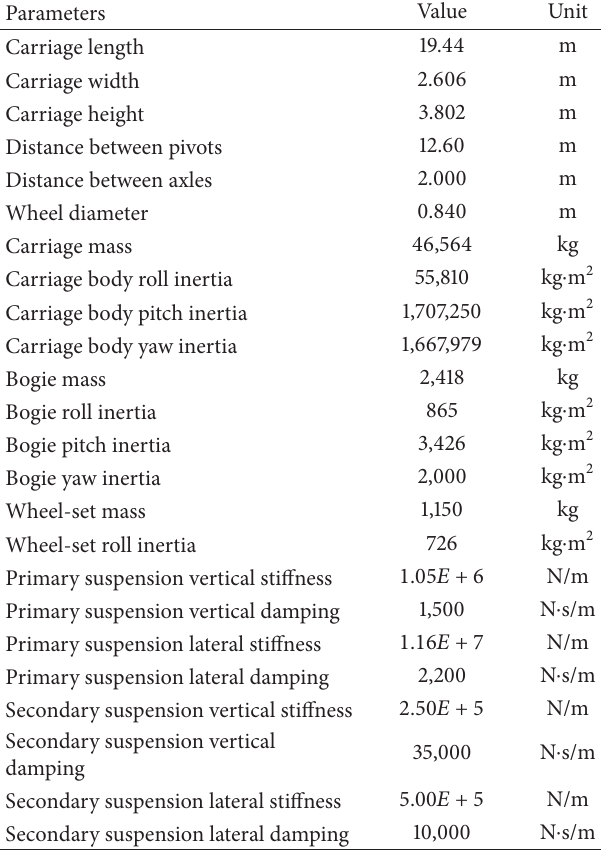
Table 3: Parameters of the